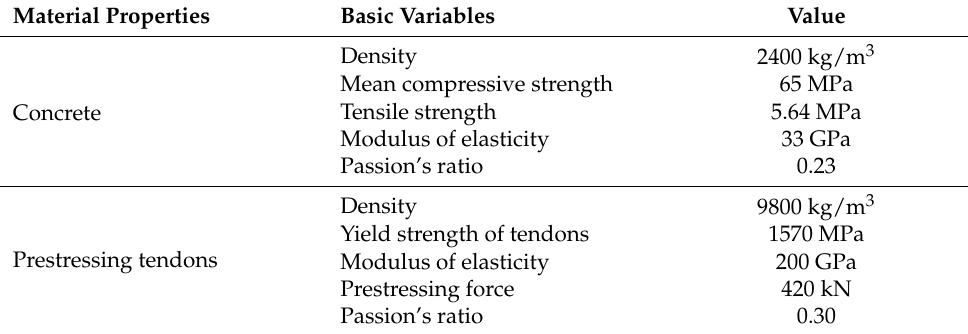
Figure 3. Crack propagation of the prestressed sleeper at midspan. Table 3. Experimental results of load-crack length response. Load (kN)